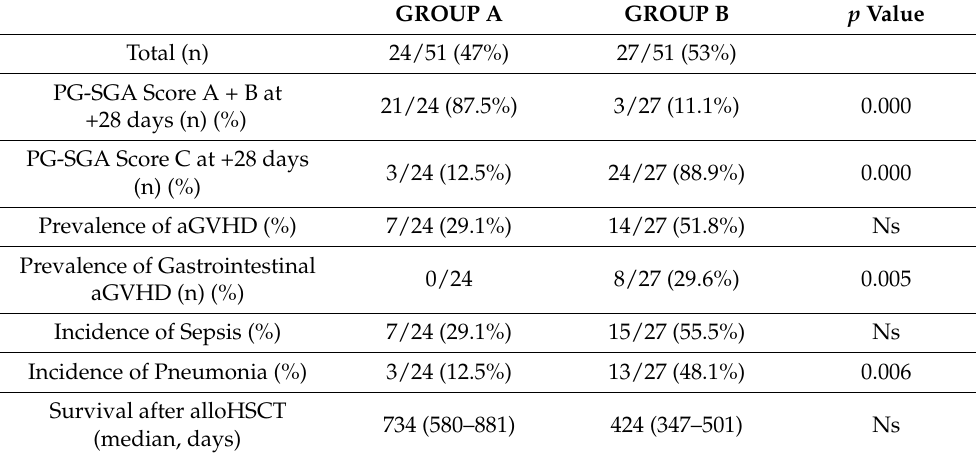
Table 3. Outcomes following treatment (A > 50% TR, B < 50%